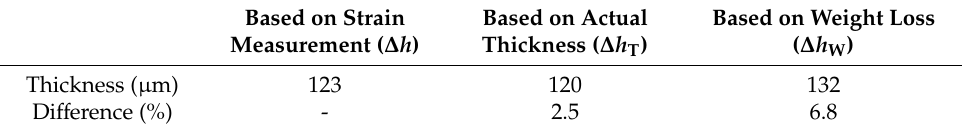
Figure 12. ( a ) Test piece in the experimental apparatus following electrolysis. ( b ) Location of points measured for evaluation of change in thickness after electrolysis. Table 2. Comparison of thickness reduction measured by thickness and weight